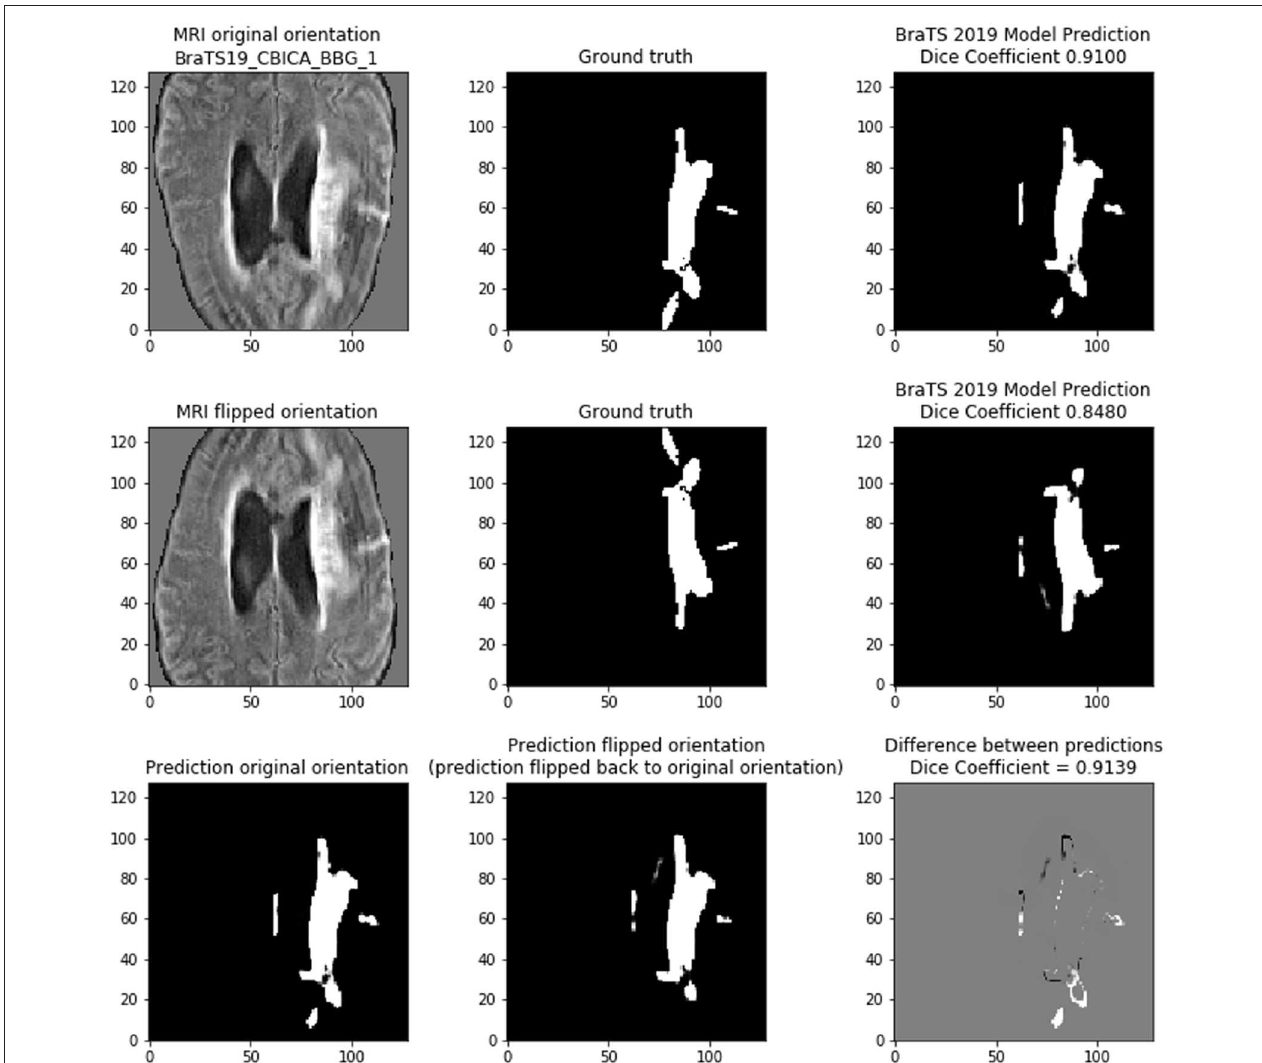
FIGURE 8 | Demonstrating the variability of the 2D BraTS model. (Top) Prediction based on normal orientation of the MRI input. (Middle) Prediction based on vertical flip of the MRI input. (Bottom) Comparing the predictions of the normal and flipped inputs. The prediction of the flipped input was re-flipped to allow direct comparison with the normal orientation prediction. In bottom right figure, gray pixels indicate no difference, black pixels are in the flipped prediction but are not present in the normal prediction, and white pixels are in the normal prediction but are not present in the flipped